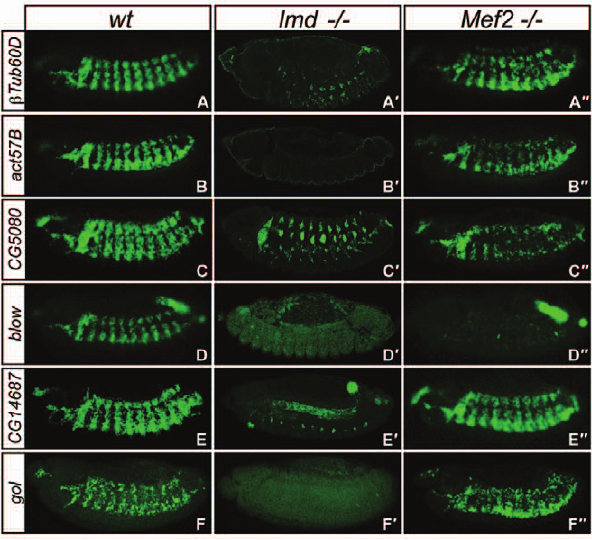
Figure 4. Shared enhancers have differential requirements for Mef2 and Lmd invivo . In situ hybridization of GFP-reporter mRNA in (A–F) wt embryos, (A 9 –F 9 ) homozygous lmd 1 mutant embryos and (A 0 – F 0 ) homozygous Mef2 P544 mutant embryos. The intronic b Tub60D enhancer requires Lmd enhancer activity (A 9 ), but remains active in Mef2 mutants (A 0 ). Similarly, activity of the act57B enhancer is strongly dependent on Lmd (B 9 ), but only mildly reduced in Mef2 mutants (B 0 ). CG5080 reporter expression is clearly reduced in both background (C 9 ,C 0 ), while activity of the blow enhancer is not detectable in the absence of either Lmd or Mef2 (D 9 ,D 0 ). The CG14687 enhancer show different requirements in different muscle types: while expression in somatic muscles requires Lmd (E 9 ), expression in the visceral muscle is not affected in neither Lmd nor Mef2 mutants (E 0 ). The gol enhancer requires Lmd activity (F 9 ) but is active normally in Mef2 mutants (F 0